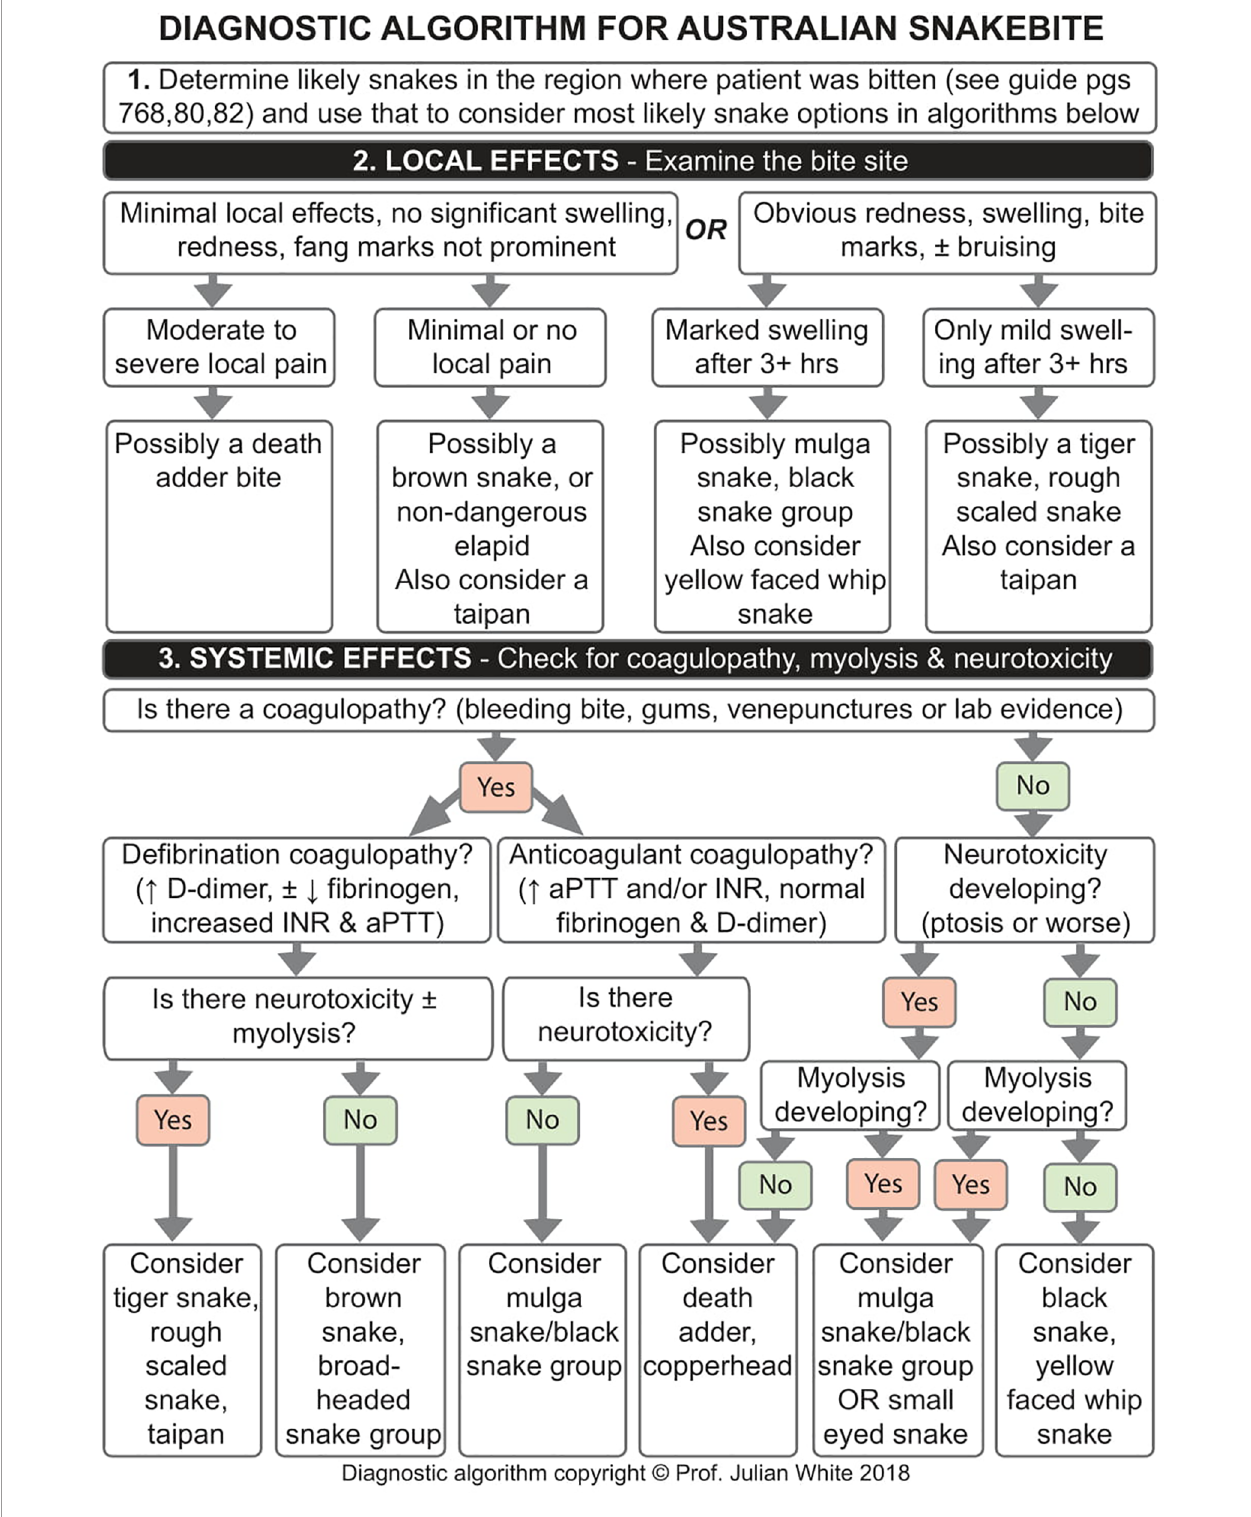
FIGURE 2 | Diagnostic algorithm for snakebite envenoming in South Australia. Algorithm copyright © Prof. Julian